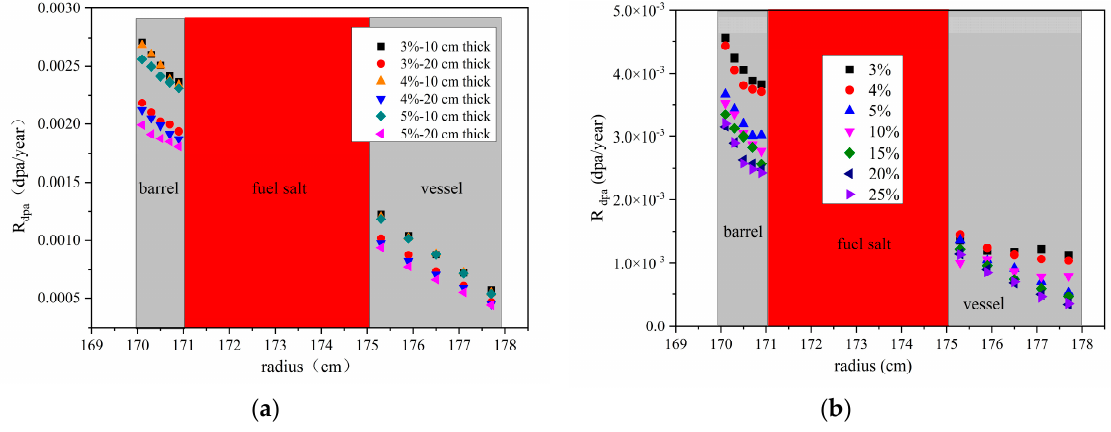
Figure 8. DPA in the reactor barrel and vessel of ( a ) scheme D and ( b ) scheme E.